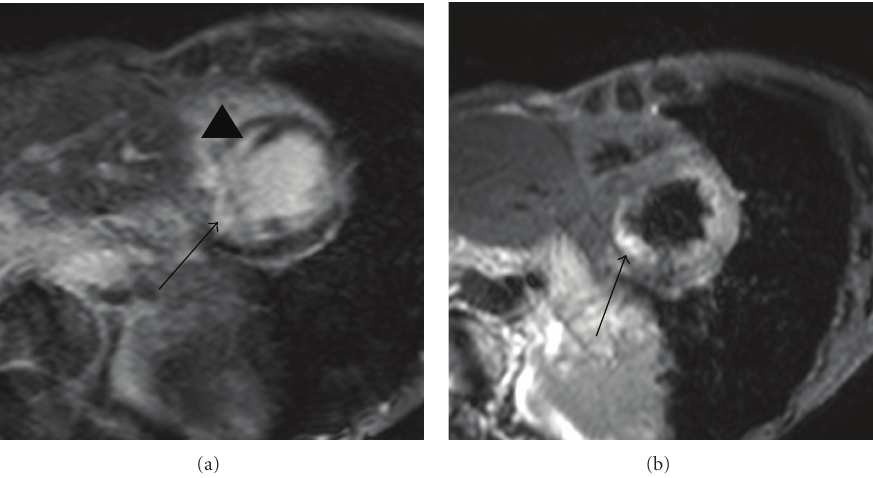
Figure 5: 73-year-old female with cardiac sarcoidosis presenting with lower ejection fraction and conduction disturbance. Short-axis delayed-enhancement MRI (a) shows abnormal enhancement consistent with the edema (arrow) as well as the septal mesocardial myocardial scarring (arrowhead). T2-weighted cardiac MRI (b) shows myocardial edema at the transmural myocardium of the inferior region (arrow).